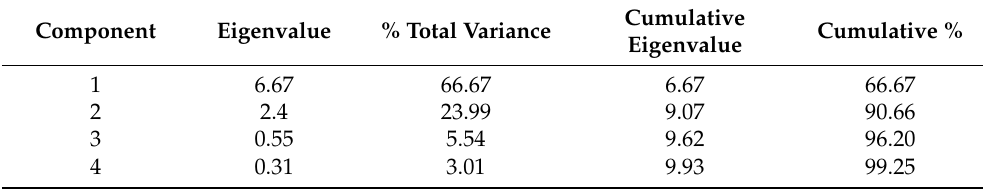
Table 3. Eigenvalues and percentages of variance are explained for each component.